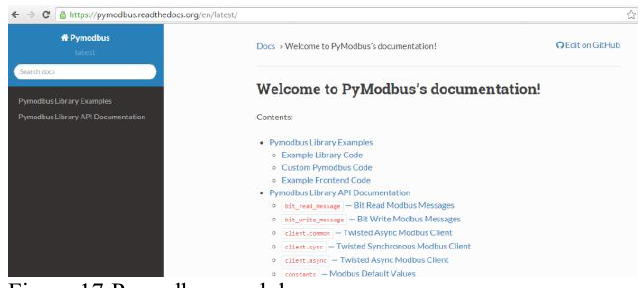
Figure 17:Pymodbus